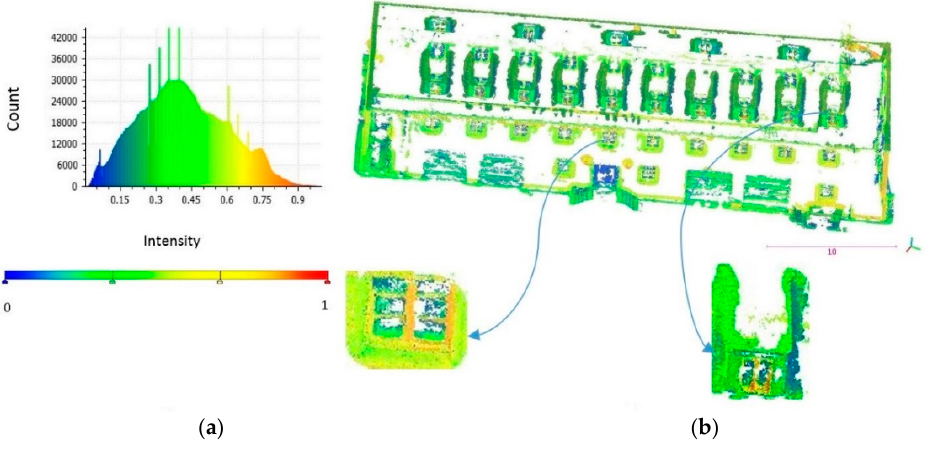
Figure 9. Employing intensity in removing the voyeur effect. ( a ) The intensity histogram, ( b ) ( a ) The intensity histogram, highlighted intensities on the point cloud, and magnification of the voyeur effect. ( b ) highlighted intensities on the point cloud, and magnification of the voyeur